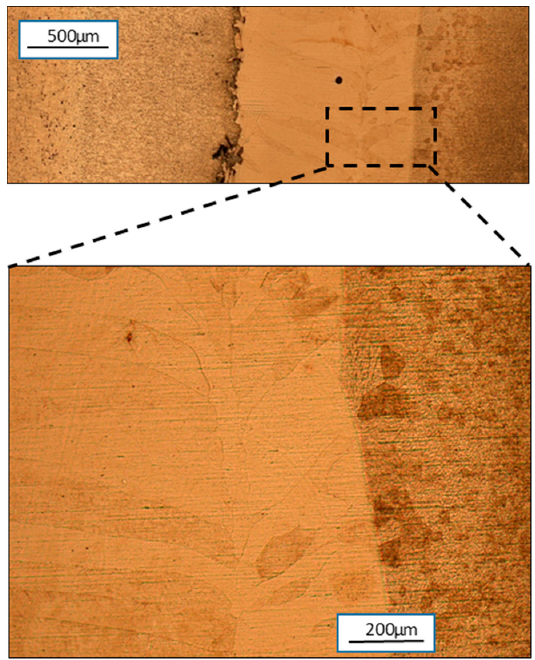
Figure 14. Interface zoom-up in the weld cross section